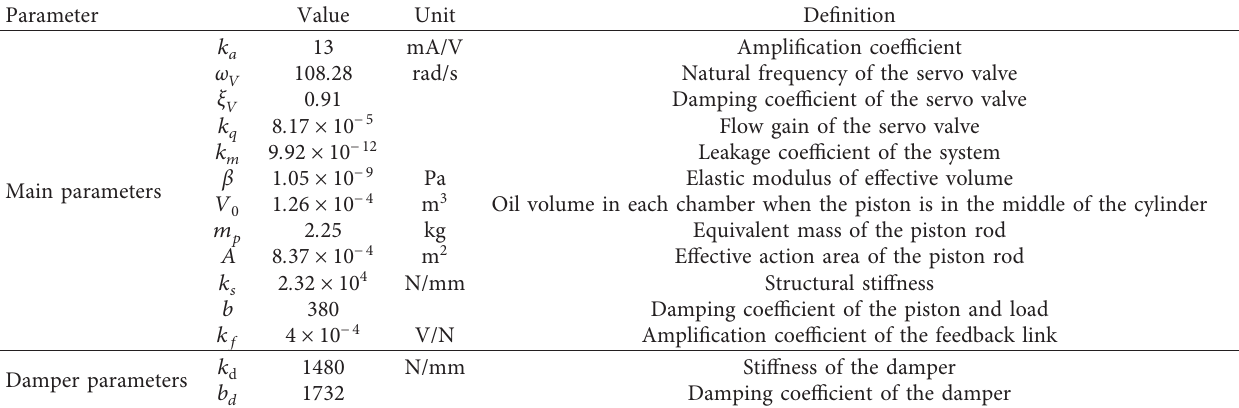
Table 3: Parameters of the EHSLS before and after